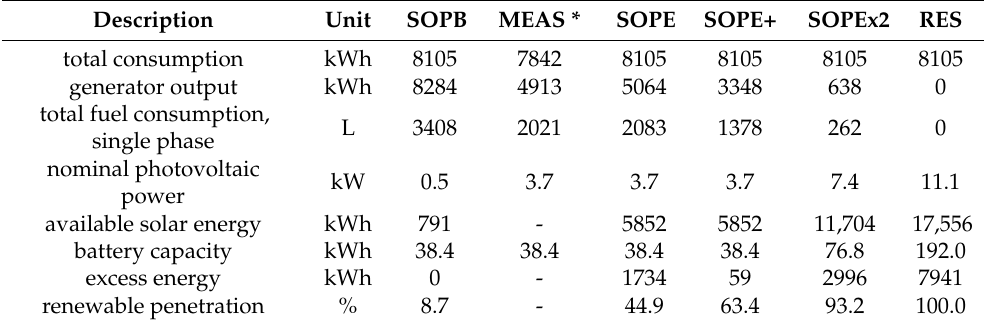
Table 2. Comparison of the measured and calculated results for different configurations.